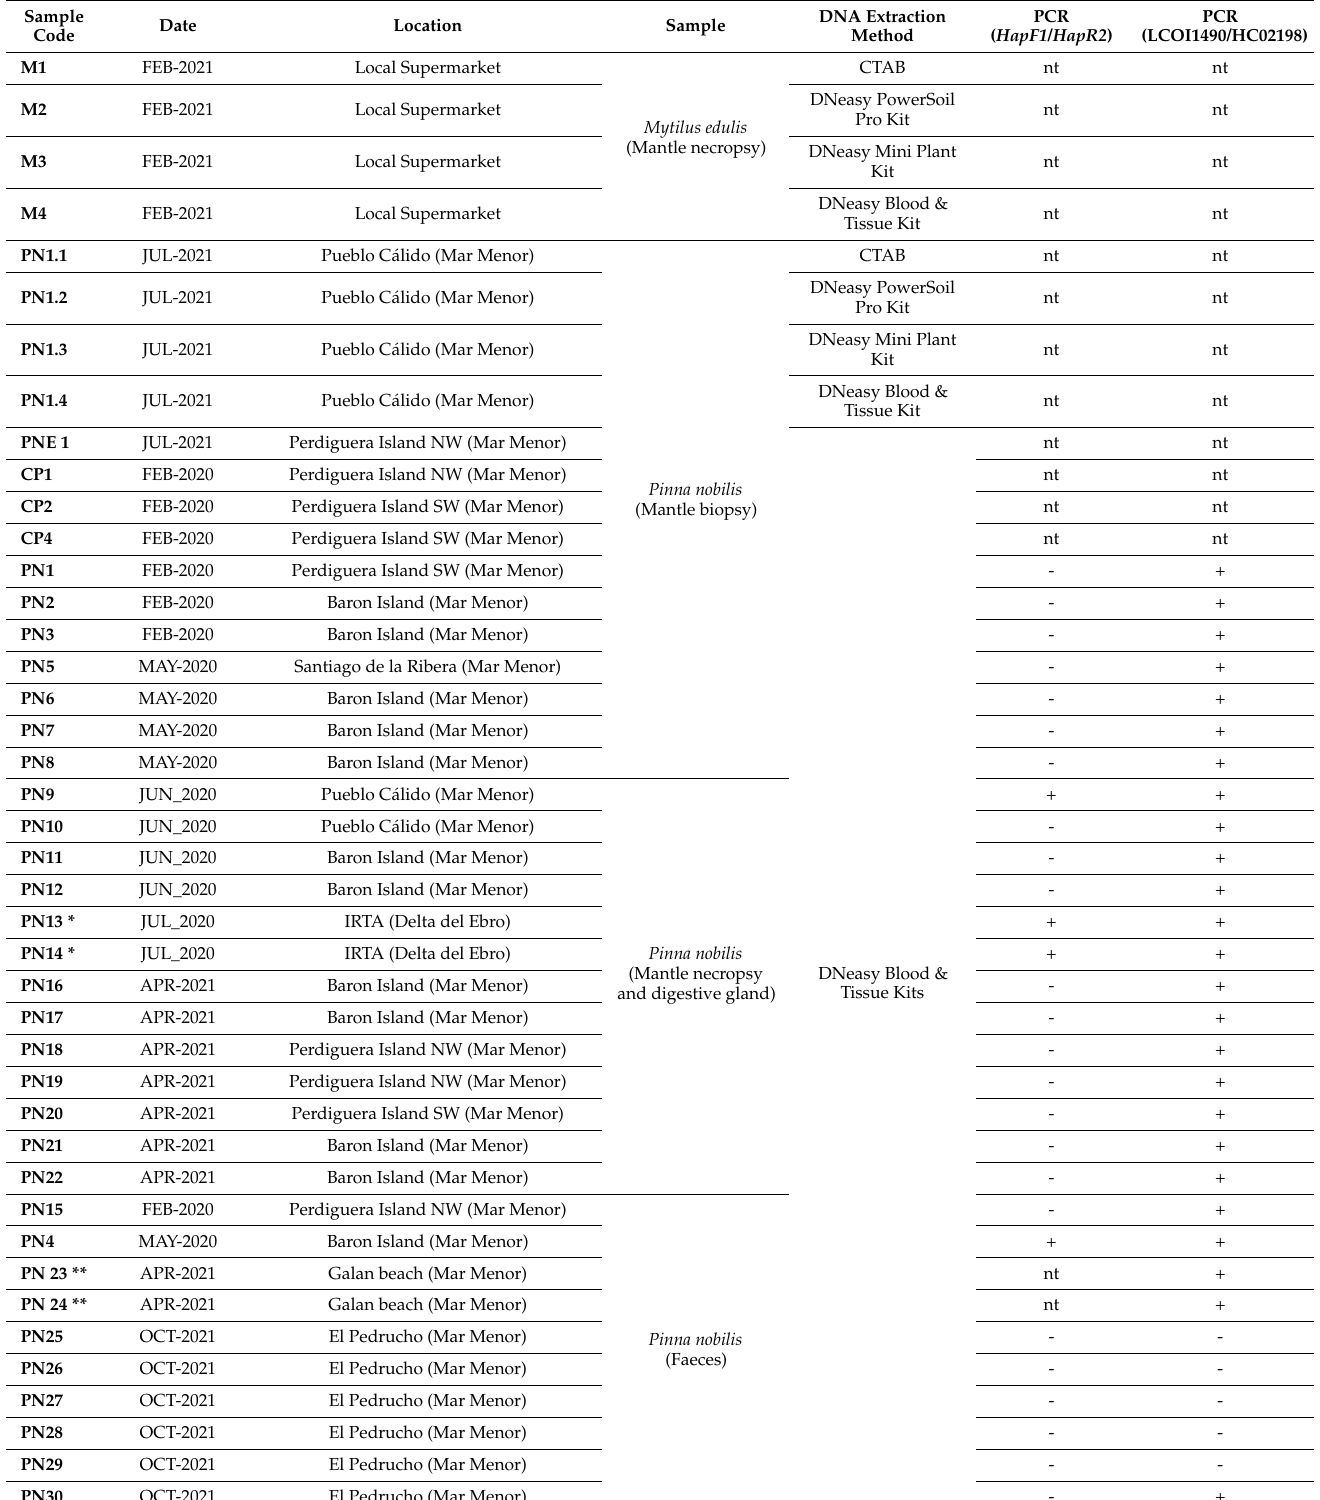
Table 1. DNA samples analysed in this